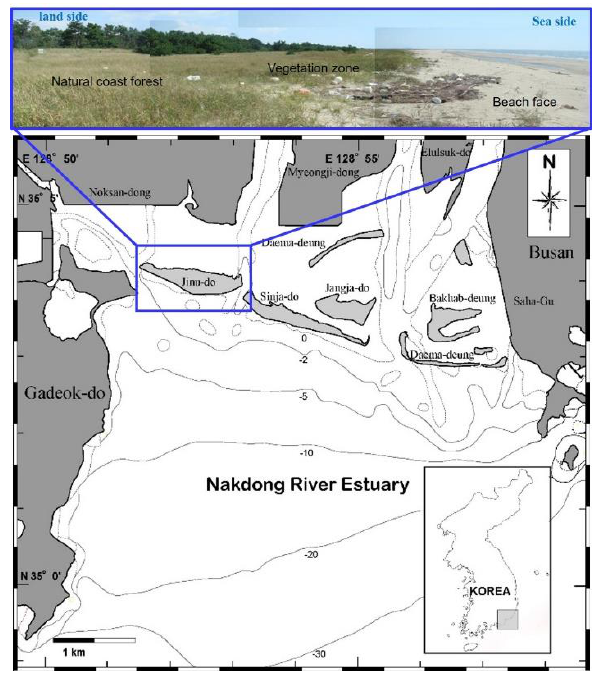
Figure 1. Panoramic view and location of Jinu-do in Nakdong River Estuary, Korea